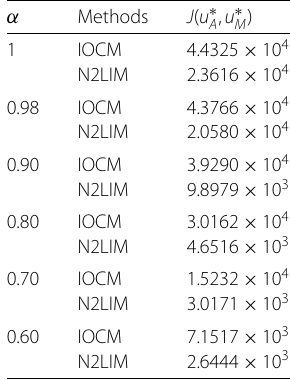
Table 2 Comparisons between IOCM, N2LIM and T f = 50, B 1 = 100, C = 1000